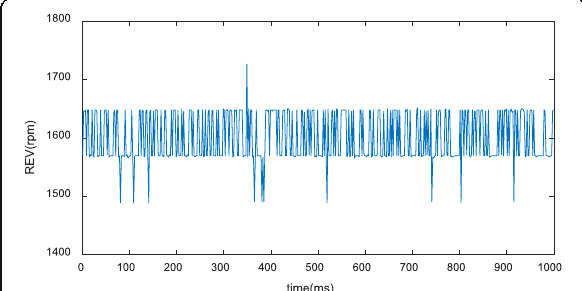
Fig. 6 Motor speed. The motor speed is set at 1600 rpm, and the actual real-time speed of the motor fluctuates near 1600 rpm. After the deceleration ratio of 16:1, the average speed of the rotating mirror is 100